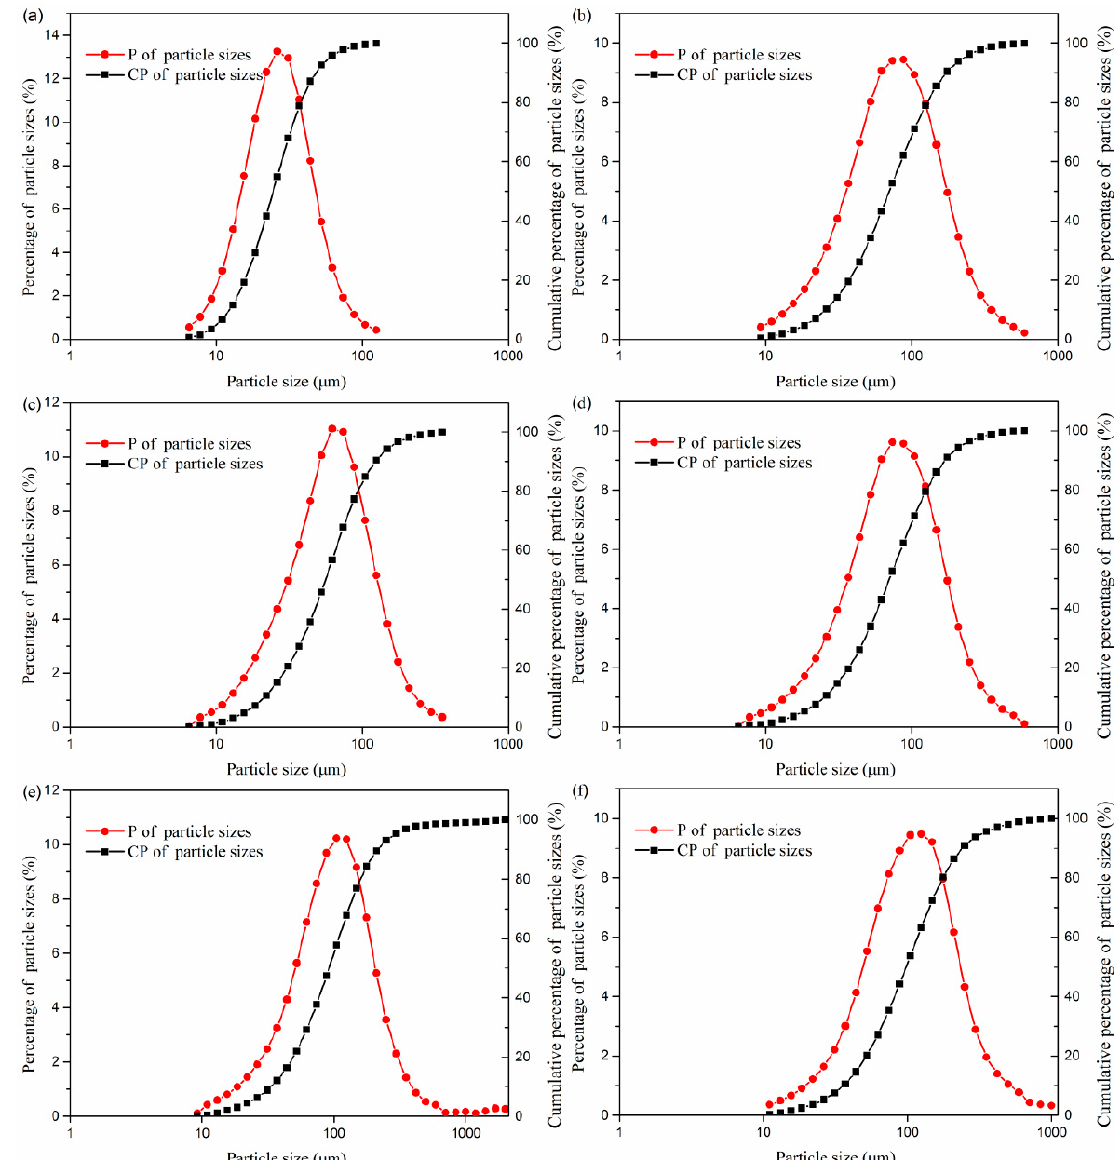
Figure 10. Percentage of different particle size distributions and cumulative percentage of different particle size distributions for the CAS system ( a , c , e ) and ABS system ( b , d , f ) under different aeration conditions: 0.15 – 0.2 L/min, 0.4 – 0.5 L/min and 0.7 – 0.8 L/min.